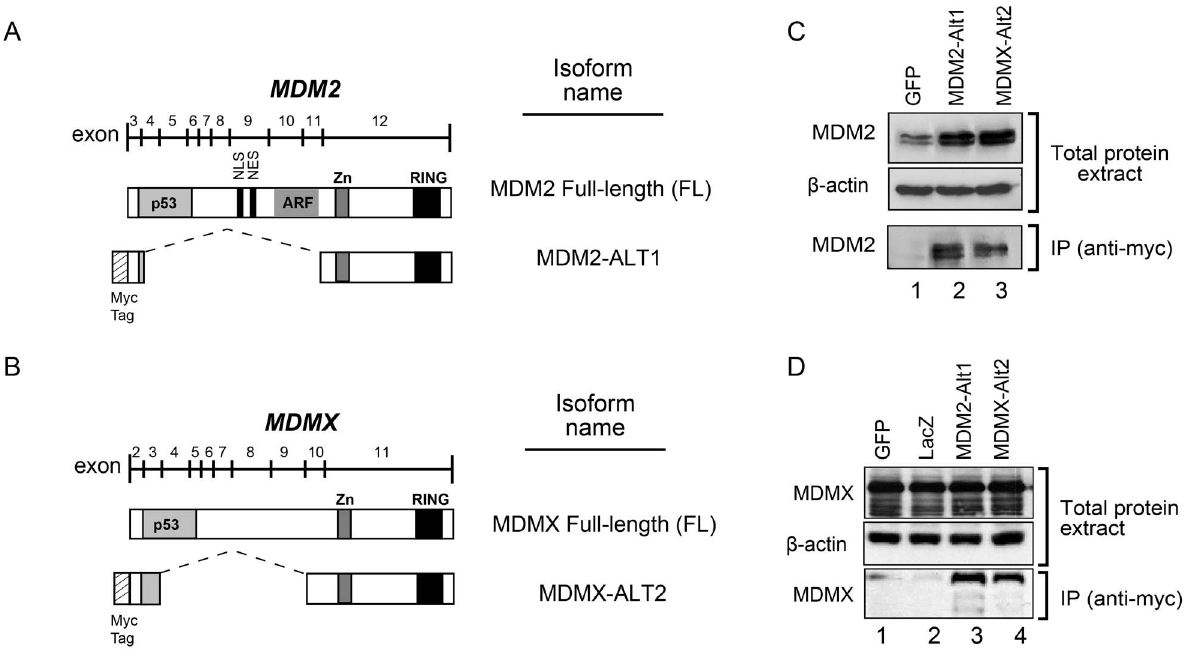
Figure 1. MDM2-ALT1 and MDMX-ALT2 interact with full-length MDM2 and MDMX. A. Full-length MDM2 is encoded by exons 3 to 12 of the MDM2 gene and consists of the N-terminal p53-binding domain, the nuclear localization (NLS) and export signals (NES), the central ARF binding and Zinc finger domains and the C-terminal RING domain. MDM2-ALT1 comprises only exons 3 and 12 spliced together and the protein lacks the p53- binding domain. However, it retains the RING domain. B. Full-length MDMX, a close family member of MDM2, also comprises an N-terminal p53- binding domain, a central Zinc finger domain and a C-terminal RING domain and is encoded by exons 2 to 11 of the MDMX gene. MDMX-ALT2 consists of exons 2,3,10 and 11 and the protein is architecturally similar to MDM2-ALT1 in that it lacks the p53-binding domain but retains the RING domain. C. Myc-tagged constructs of LacZ, MDM2-ALT1 or MDMX-ALT2 were transfected into MCF7 cells. Immunoprecipitation of the myc-tagged proteins revealed the specific binding of full-length MDM2 to MDM2-ALT1 and MDMX-ALT2 and not to negative control protein myc-LacZ (compare lanes 2 and 3 to lane 1). Experiments were repeated a minimum of three times and consistent results were observed. Representative gel images are presented in the figure. D. Myc-tagged MDM2-ALT1 and MDMX-ALT2 co-immunoprecipitate with full-length MDMX while the negative control protein myc-LacZ does not interact with MDMX (compare lanes 2 and 3 to lane 1). These results were observed in two independent trials and representative images are